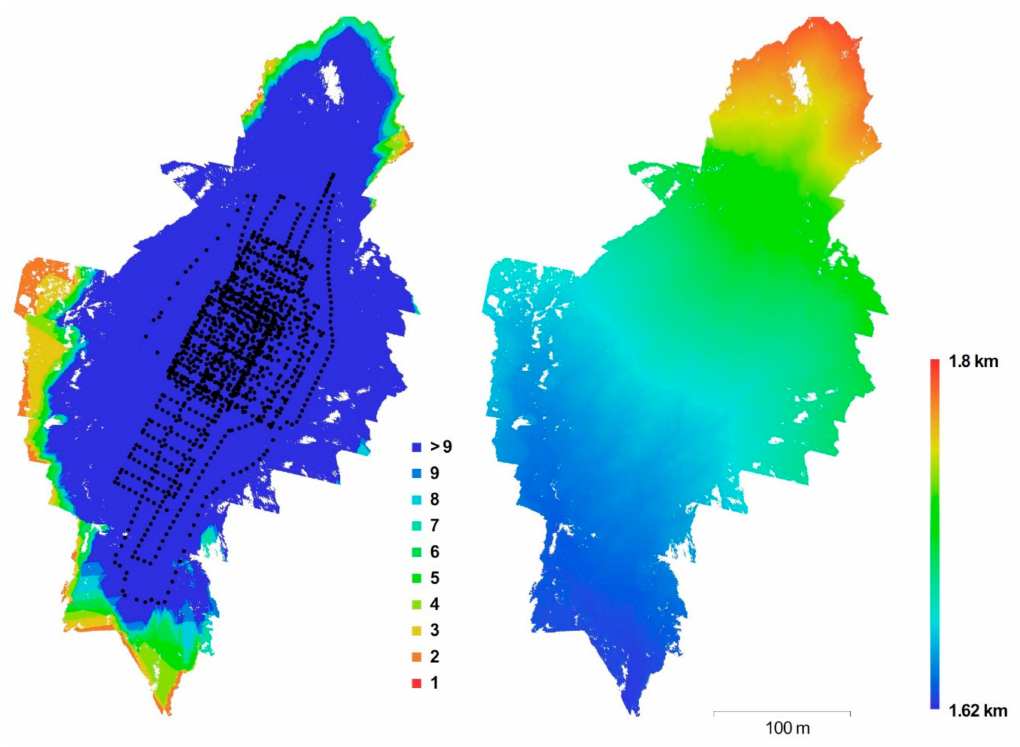
Figure 10. The number of UAS images capturing the area and the flight plan; dots represent camera positions during image acquisition (left) and reconstructed digital elevation model with the color scale shows altitudes